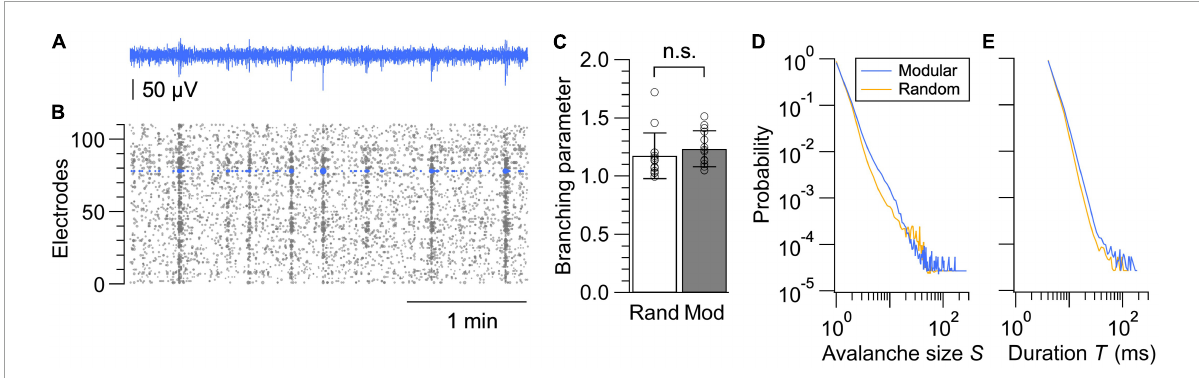
FIGURE5 Neuronal avalanche analysis. (A) LFP signal from a representative electrode. (B) nLFPs extracted from all electrodes in a modular network. Marker sizes are varied proportional to their amplitudes. (C) Branching parameters calculated from the random and modular networks. Data shown as mean ± SD, with plots for individual data points. n.s., no significance (two-tailed t -test). (D,E) Size distributions (D) and duration distributions (E) of neuronal avalanches in random and modular networks. Networks with sufficient activity were selected based on the same criteria used for the analysis in Figure 4A , and average probability distributions calculated from 14 networks are shown for both the random and modular